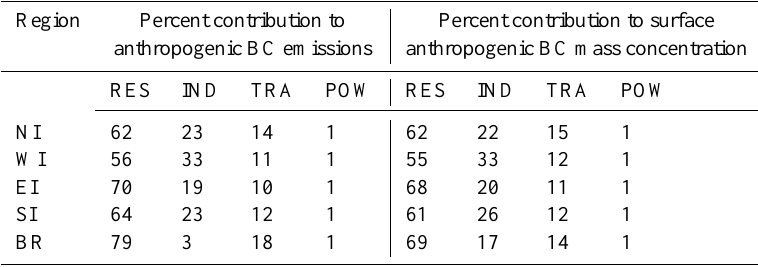
Table 5. Percent contributions of residential (RES), industrial (IND), transport (TRA) and power generation (POW) sectors to the total anthropogenic emissions and to the surface anthropogenic BC mass concentrations in north (NI), west (WI), east (EI) and south India (SI) and in Burma